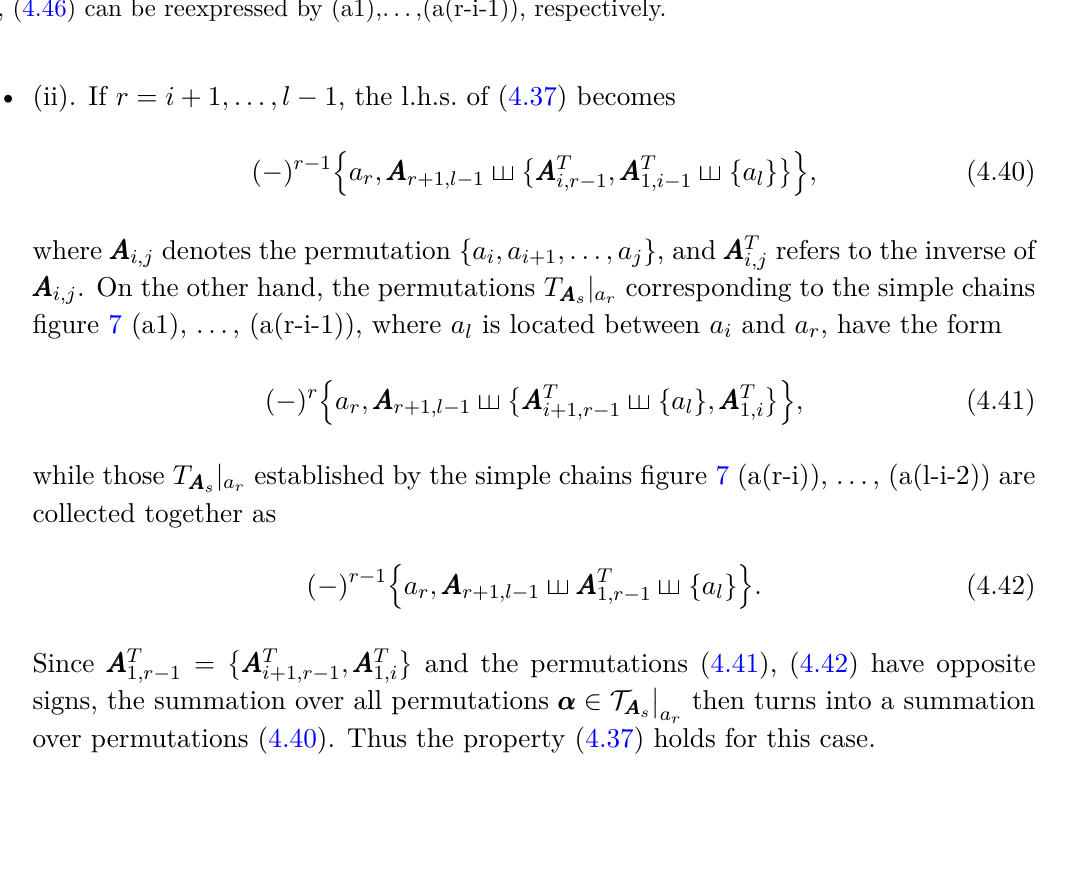
Figure 8 . Graph (a) is constructed by planting a simple chain with nodes { a j +1 , . . . , a l } at a i . Ac- cording to the inductive assumption, the simple chains corresponding to permutations (4.44), (4.45), . . . , (4.46) can be reexpressed by (a1),. . . ,(a(r-i-1)),